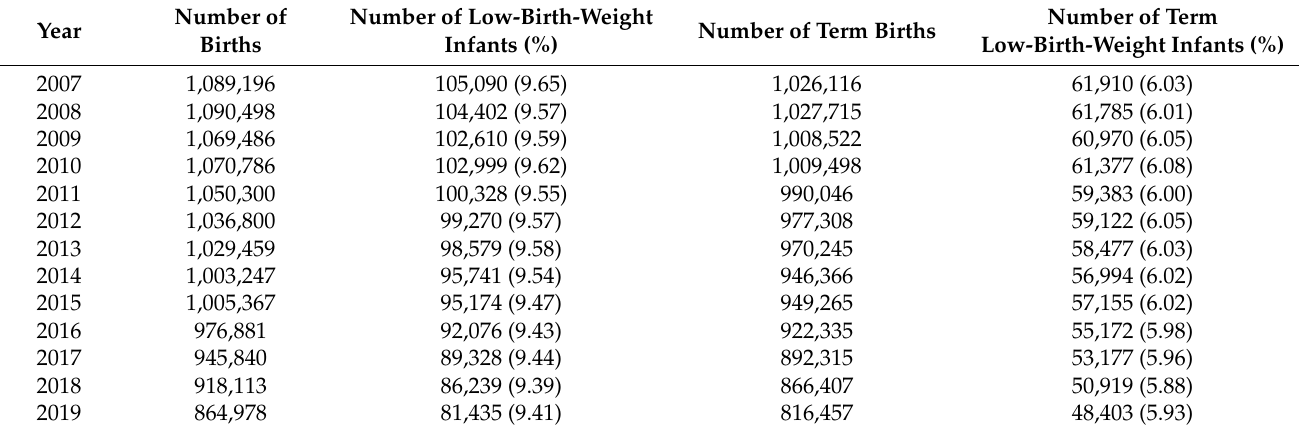
Table 1. Yearly number of births, low-birth-weight infants, number of term births, and term low- birth-weight infants in Japan.